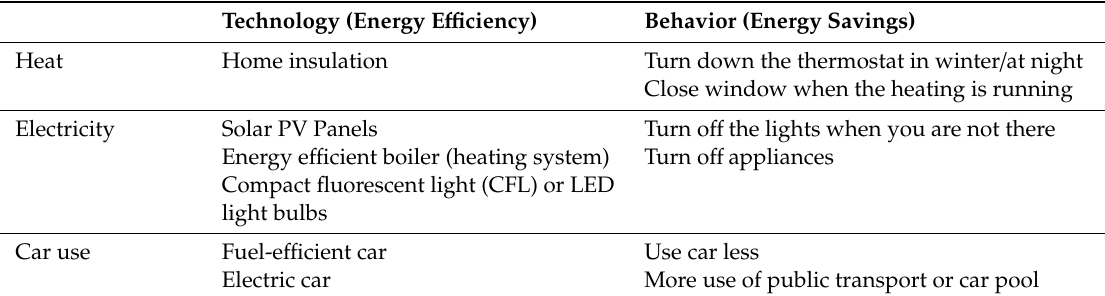
Table 2. List of technological and behavioral energy saving measures.